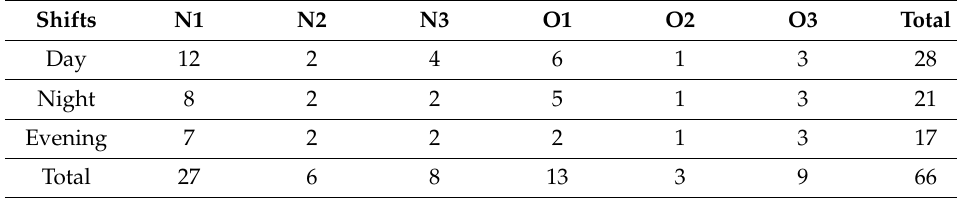
Table 3. The number of nurses scheduled per day.